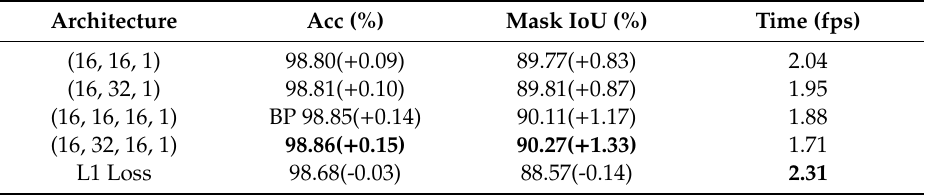
Table 2. The intersection over union (IoU) of Res34-UNet with BP loss on the WHU dataset.